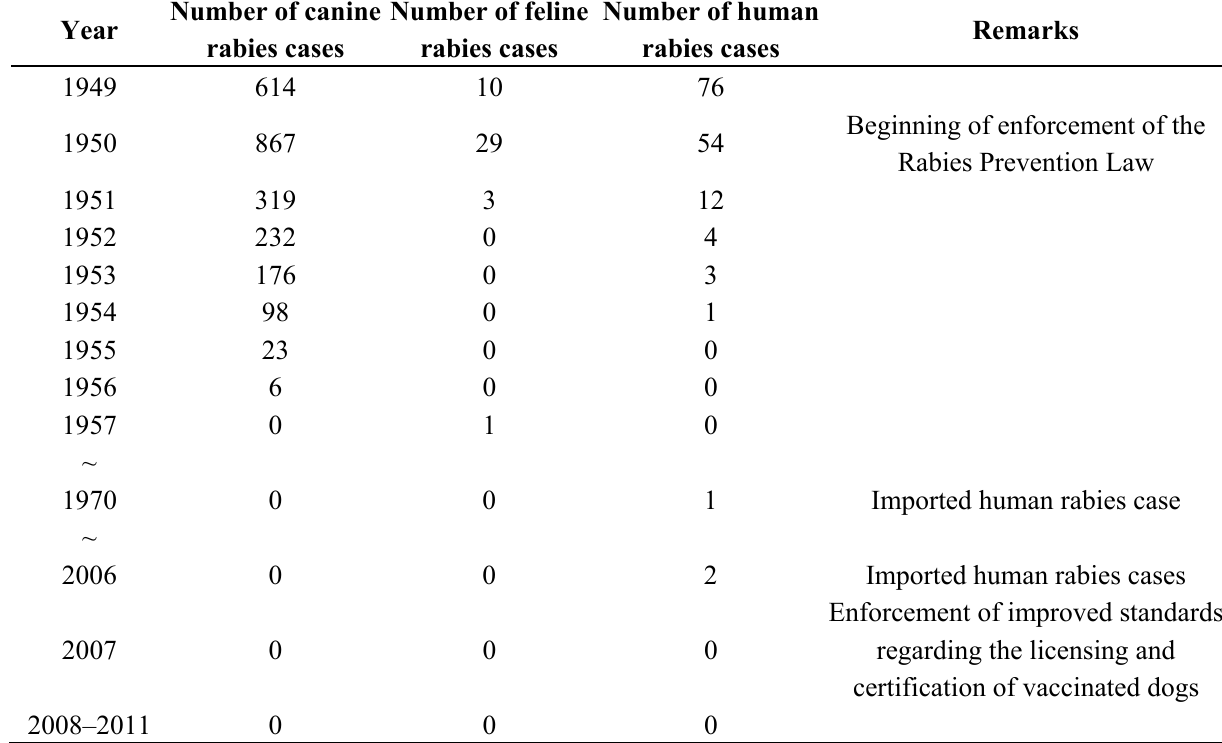
Table 3. Annual number of animal and human rabies outbreaks in Japan. Numbers in parentheses refer to cases of feline